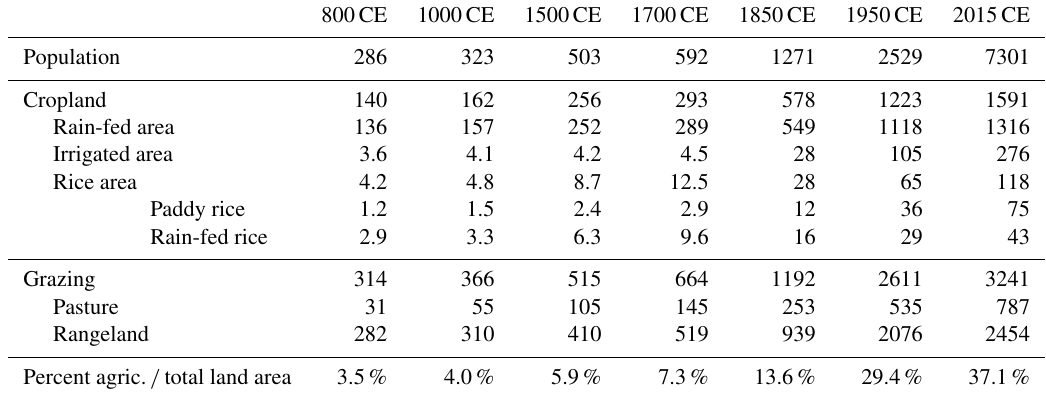
Table 1. Historical global population (millions) and land use estimates (million of hectares) from HYDE 3.2 (Klein Goldewijk et al.,